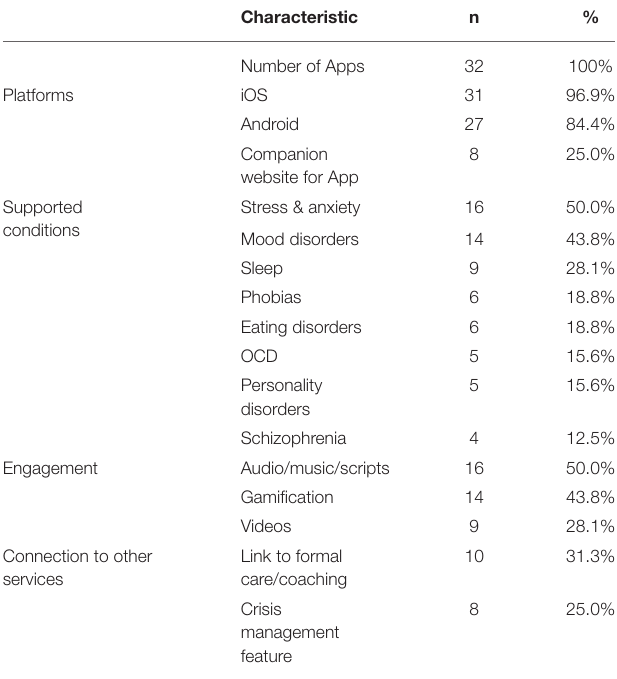
TABLE 1 | Characteristics of mental health mobile apps in